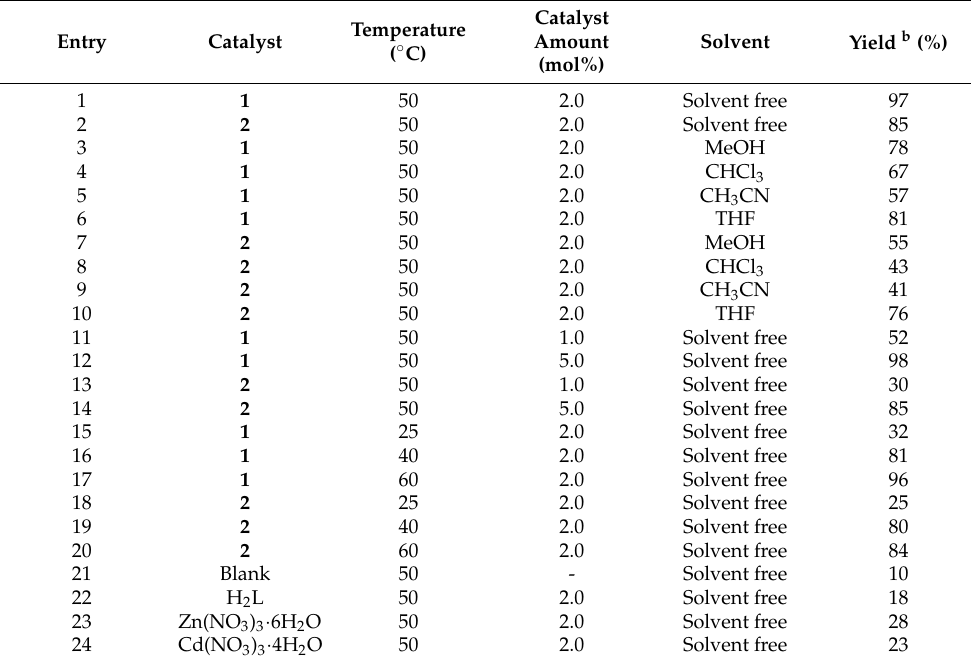
Table 1. Cyanosilylation of benzaldehyde with trimethylsilyl cyanide (TMSCN) with coordination polymer 1 or 2 as catalyst a